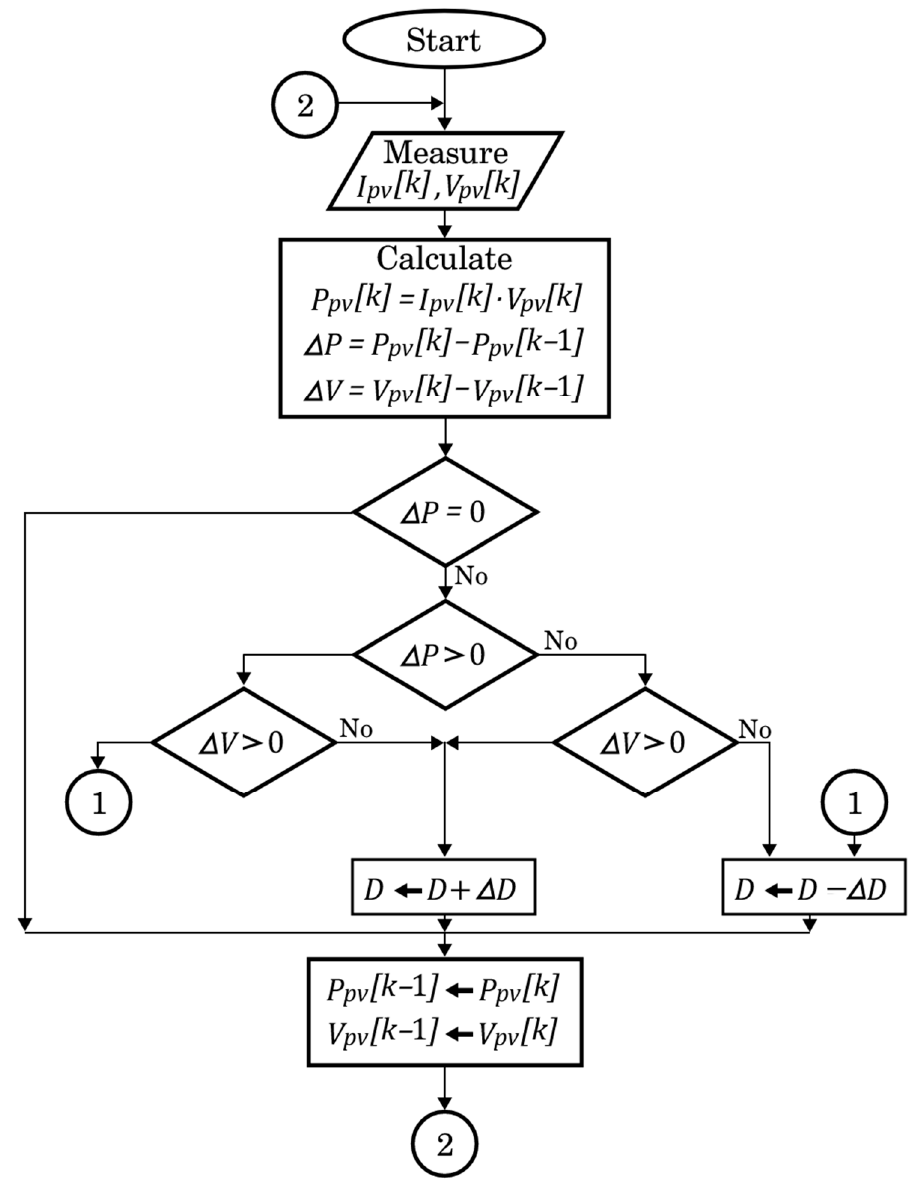
Figure 4. Flowchart of the P&O algorithm for the SEPIC converter.